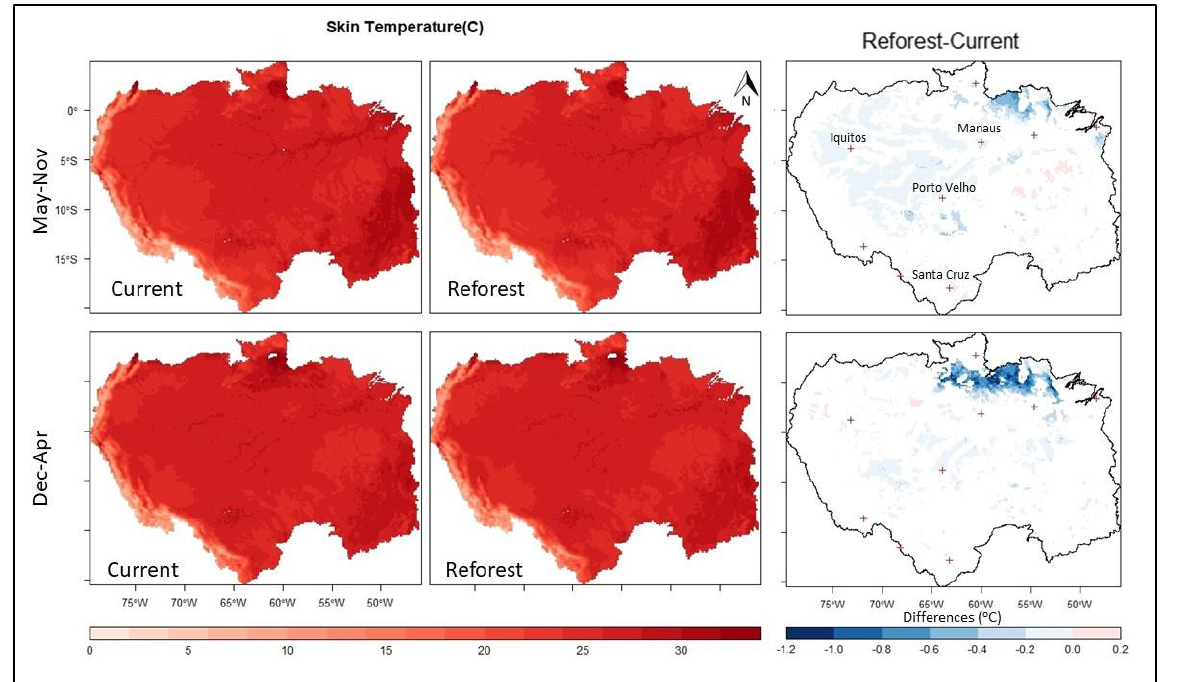
Figure 6. Simulated temperature, forced with current and reforested land cover on the left. On the right, the difference between the two simulated temperatures is at a 95% significance level. Plus signs indicate major cities.